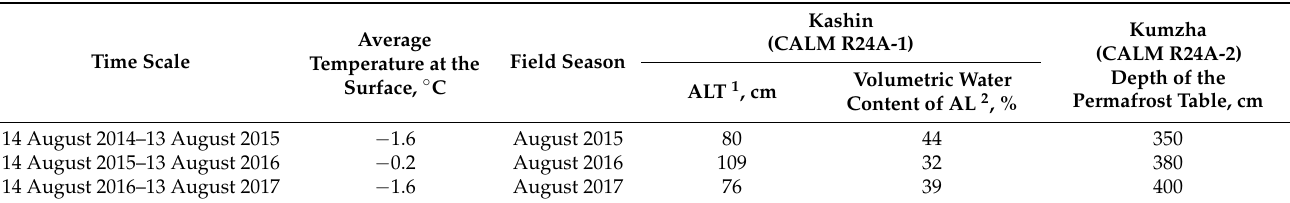
Table 2. Summarized monitoring results at the CALM 24A-1 and CALM 24A-2